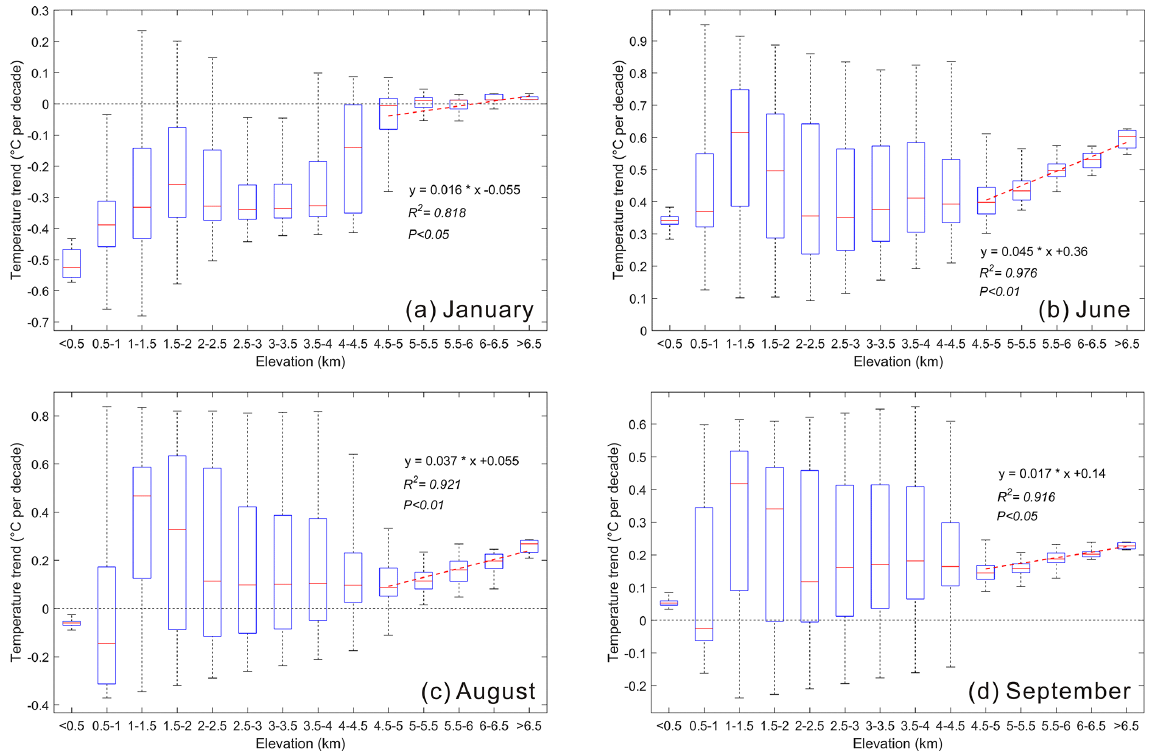
Figure 3. Box plots of monthly mean temperature trends at different altitudes from 1979 to 2016. (a) January, (b) June, (c) August and (d) September. Thick horizontal lines in boxes show the median values. Boxes indicate the inner-quartile range (25% to 75%), and the whiskers show the full range of the values. The red dashed lines represent the significance of EDW by fitting the temperature trends and altitude groups above